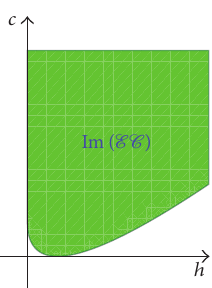
Figure 1: The image of the energy-Casimir mapping.